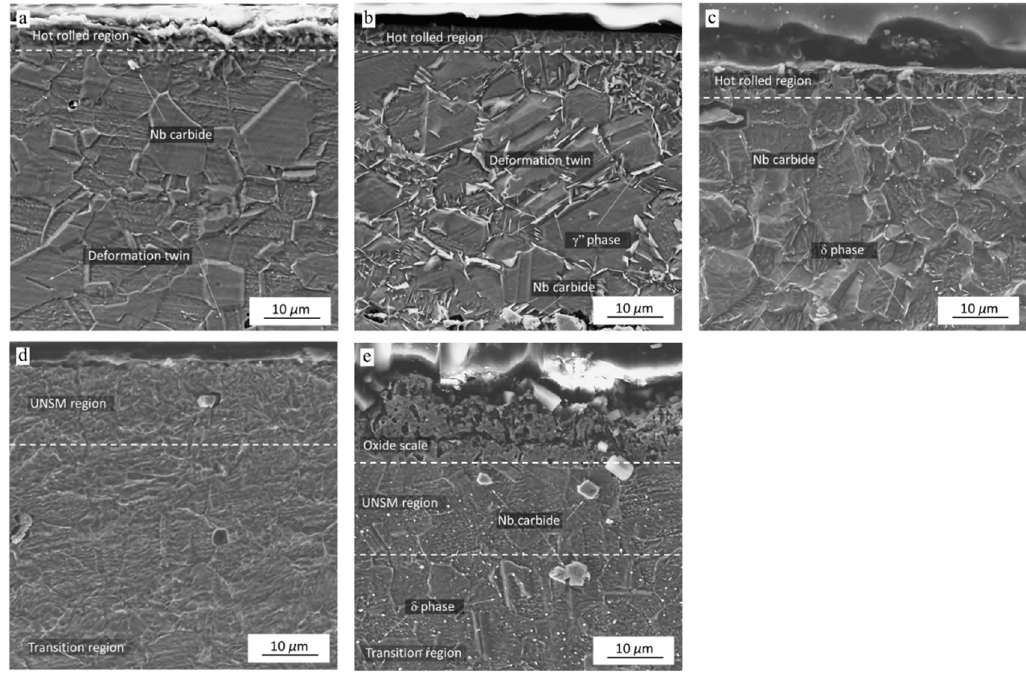
Figure 9. SEM images showing the area close to the treated surface of Inconel 718: ( a ) As-received sample ( × 2000); ( b ) I1 sample ( × 2000); ( c ) I2 sample ( × 2000); ( d ) I3 sample ( × 2000); ( e ) I4 sample ( × 2000). Table 5. δ phase area and volume fraction coverage for Samples I2 and